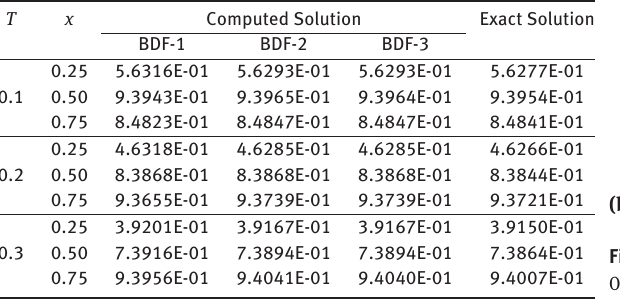
Table 2: Numerical solutions obtained by proposed schemes and the exact solutions for Example 1: ν = 0.02 , Δx = 0.0125 and Δt = 0.001 .